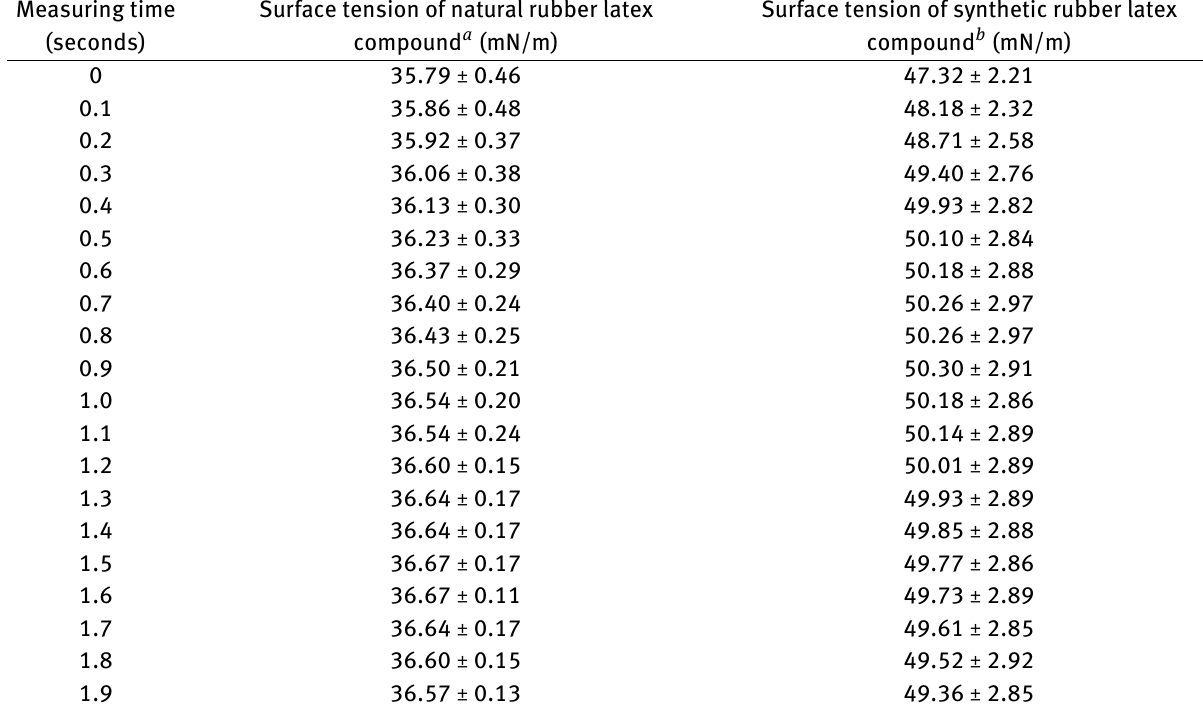
Table 8: Mean surface tension ( ± SD) of natural and synthetic rubber latex compounds for preparation glove films Measuring